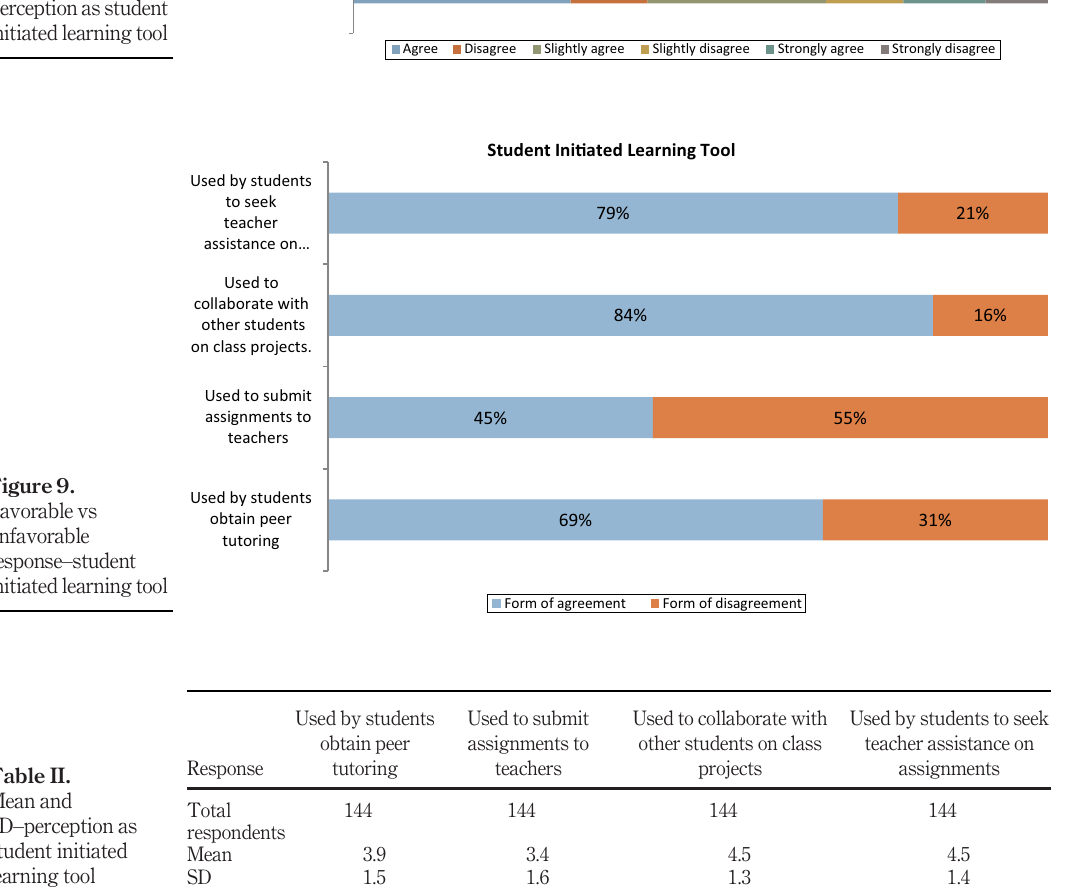
Figure 8. Perception as student initiated learning tool